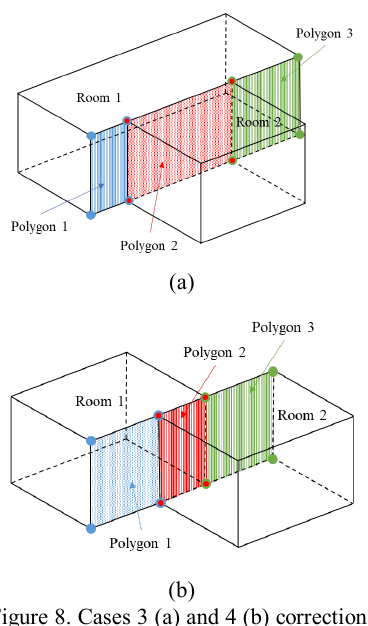
Figure 8. Cases 3 (a) and 4 (b)